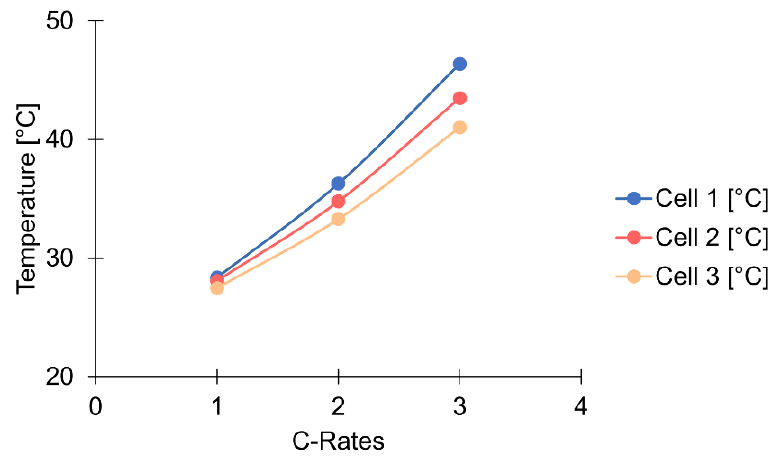
Figure 14. Comparison of the maximum temperature reached by each cell during the fast charge experiments with Novec™ 649. Measures have an accuracy of ±0.5 °C (T-type thermocouples). Table 8. Comparison of maximum cell temperatures during the fast charge tests, together with the maximum temperature difference across the module. Results are provided with the uncertainty associated with calibrated T-type thermocouples (±0.5 °C and 0.7 °C for the ∆ measurement).